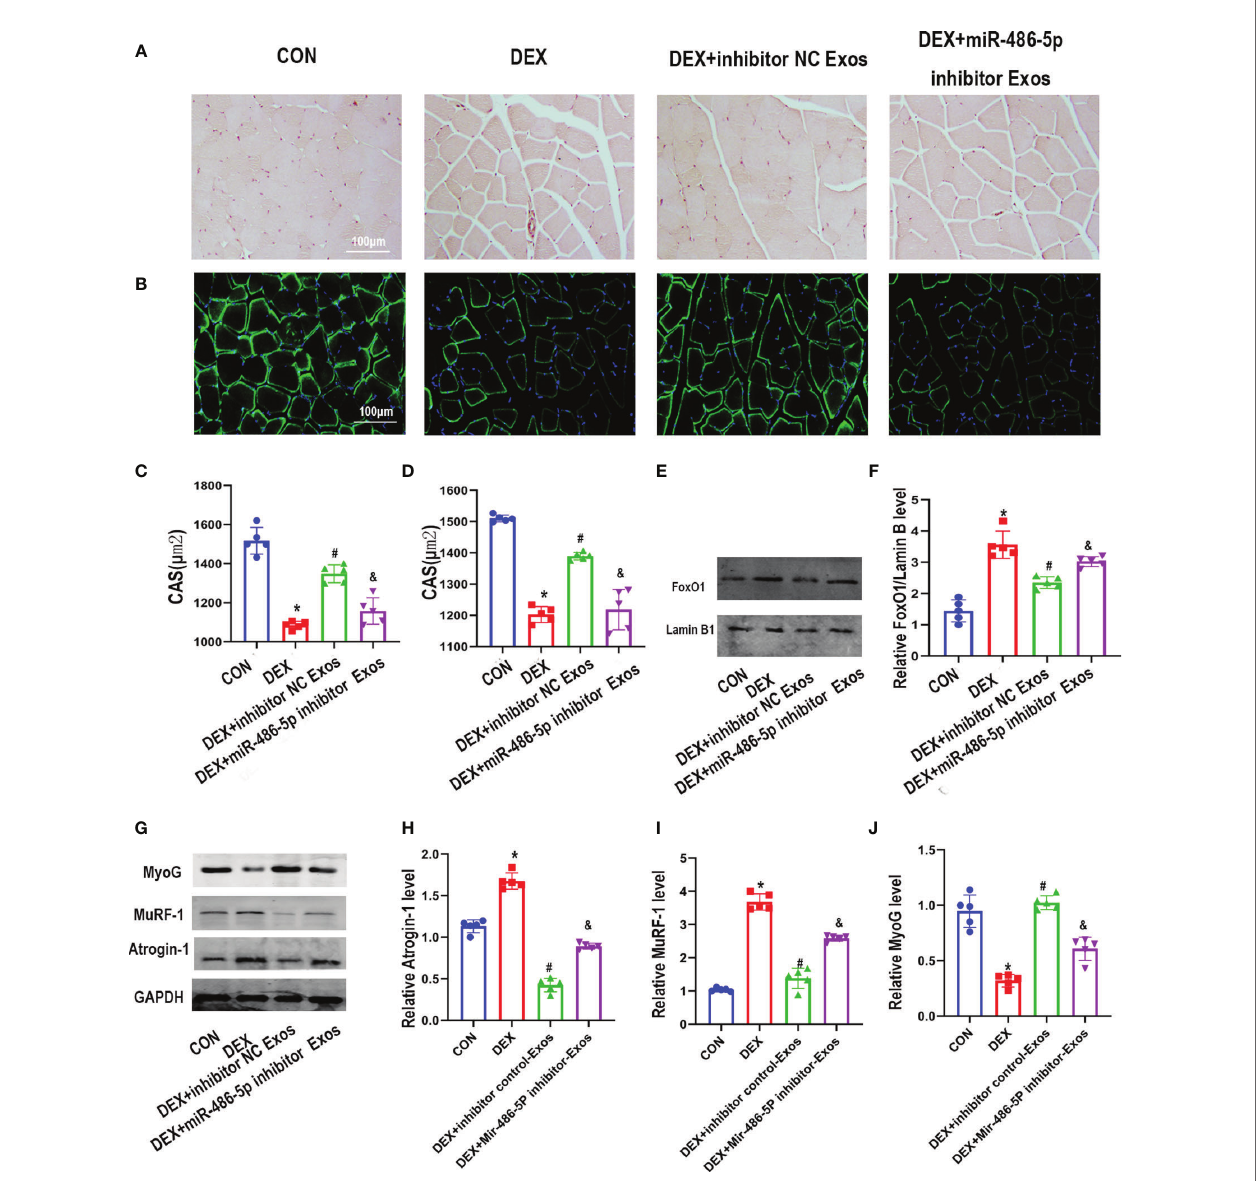
FIGURE 6 | BMSC-Exos inhibited DEX-evoked muscle loss in vivo . (A) Cross-sectional area (CSA) of muscle were captured by H&E staining and quanti fi ed (C) (n = 5). scar bar = 100µm. (B) CSA of muscle were captured by immunostaining with laminin antibody and quanti fi ed (D) (n = 5). scar bar = 100µm. (E, F) The protein level of FoxO1 in nuclear was measured by Western blot analysis (n = 5). (G – J) The protein level of Atrogin-1,MuRF-1and MyoG in muscle was measured by Western blot analysis (n = 5). *p < 0.05 compared to the control group. # p < 0.05 compared to the DEX group. & p < 0.05 compared to the inhibitor NC